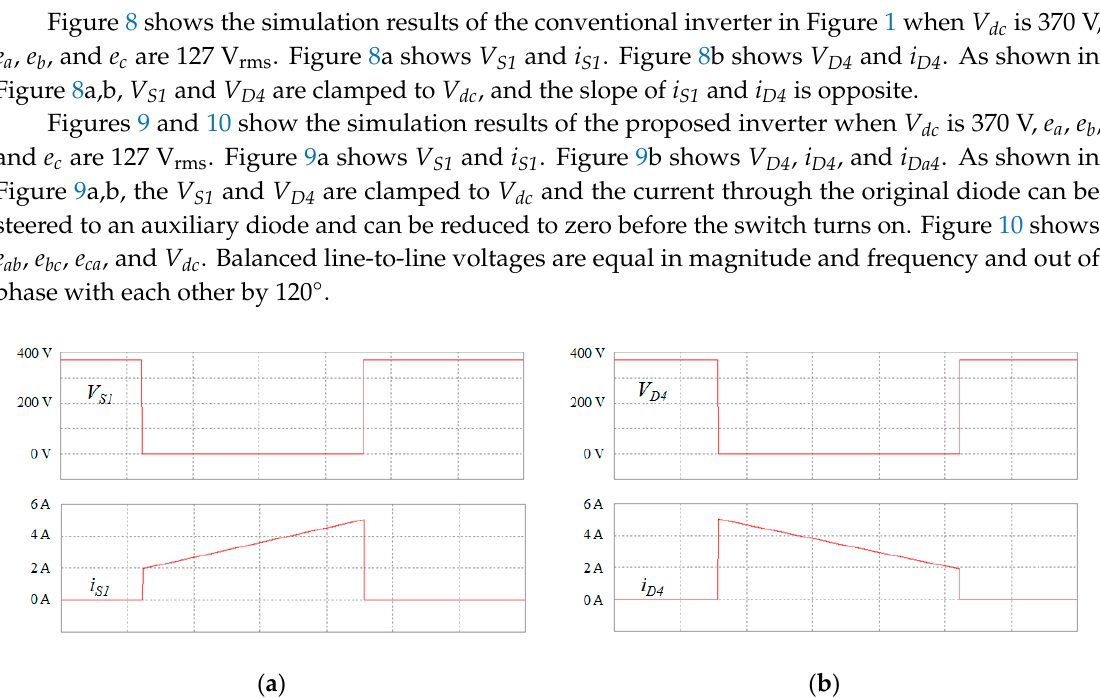
( b ) Figure 9. Simulation results of the proposed inverter: ( a ) V S1 and i S1 ; ( b ) V D4 , i D4 , and i Da4 . Figure 10. Simulation results of the proposed inverter: e ab , e bc , e ca , and V dc . 3.2. Experimental Results To evaluate the performance of the proposed inverter, we built and tested a 1.0 kW prototype inverter. The conventional inverter was also designed for the performance comparison with the proposed inverter. The electrical specifications of the prototype inverter are shown in Table 1. Table 2 shows the component parameters of the prototype inverter. The hardware prototype is divided into two parts: the microprocessor-based control circuit and the power circuit. We have implemented the control block diagram of the proposed inverter, as shown in Figure 7, by using a dsPIC30F6015 (Microchip Technology, Chandler, AZ, USA) 16-bit fixed point digital signal controller. We have measured the signals using an analog to digital converter in the microprocessor. The controllers have been executed for every sample period of 100 μ s.